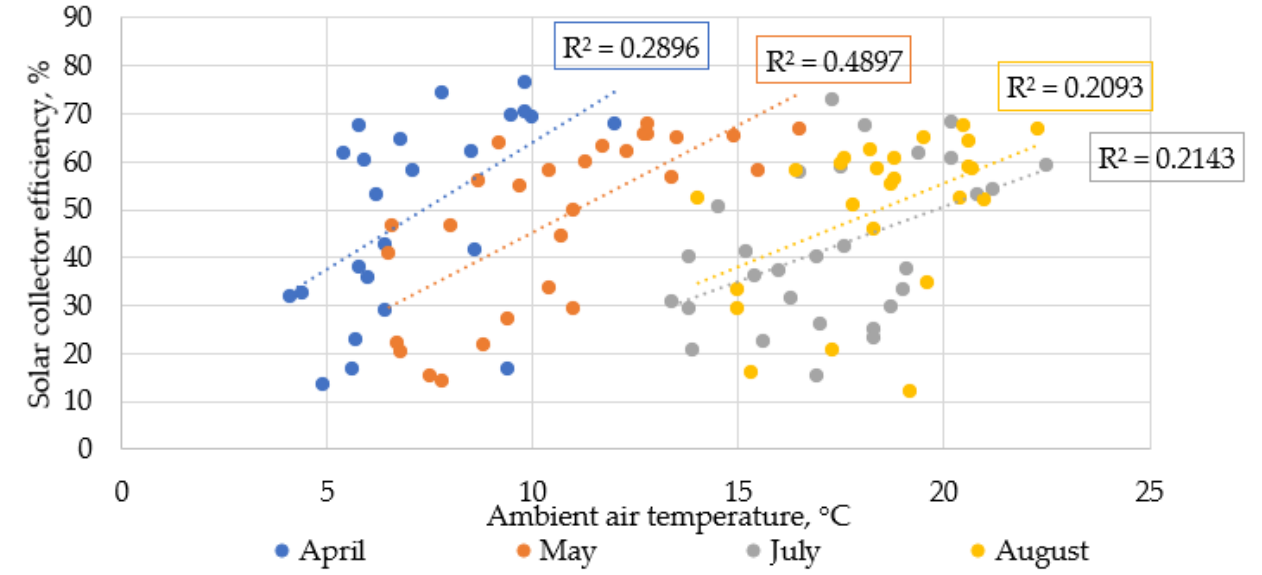
Figure 7. Solar collector efficiency dependency on ambient air temperature.